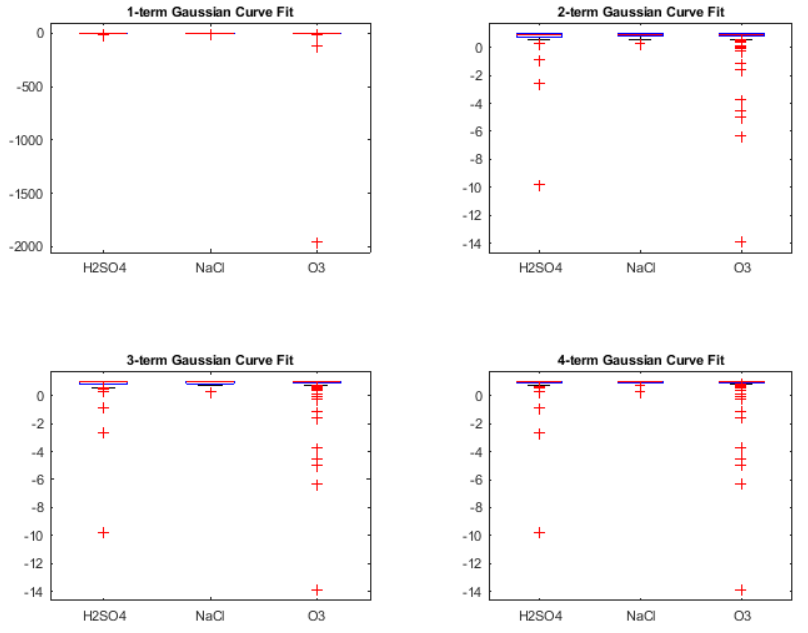
Figure 7. R-squared values for Gaussian curve fitting.